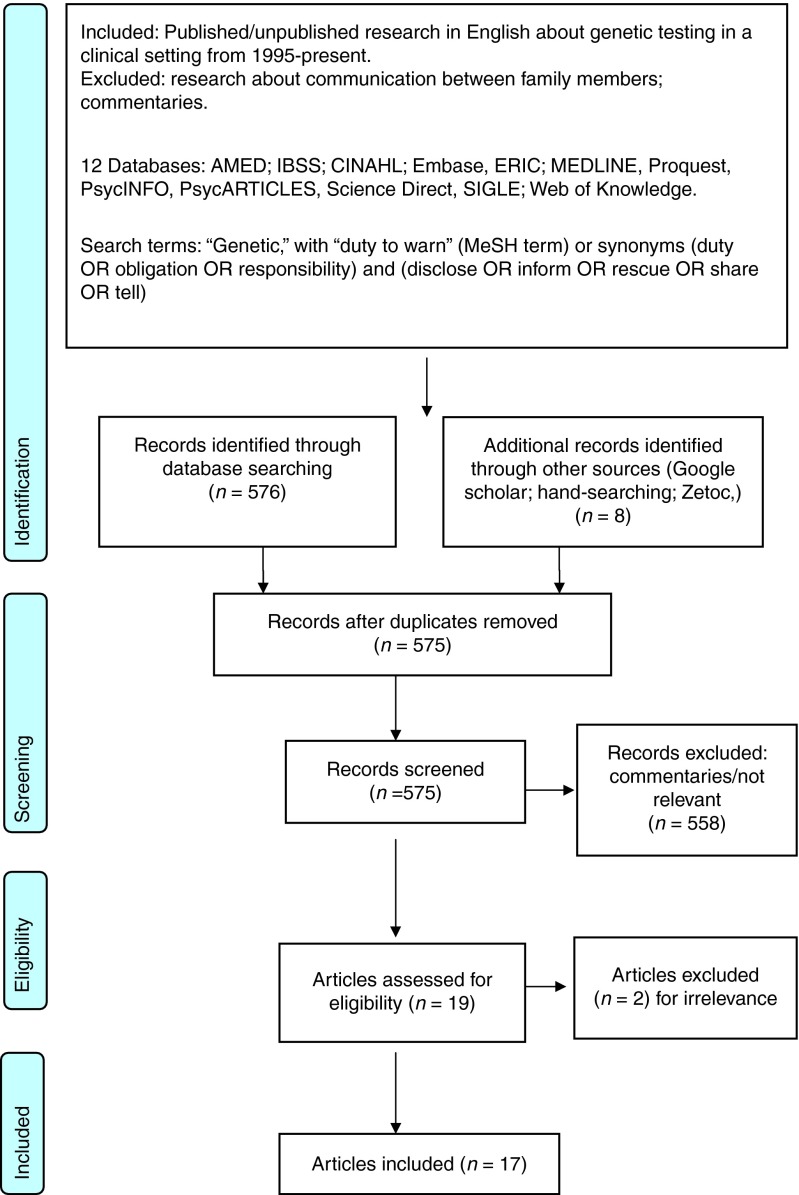
PRISMA flow diagram.